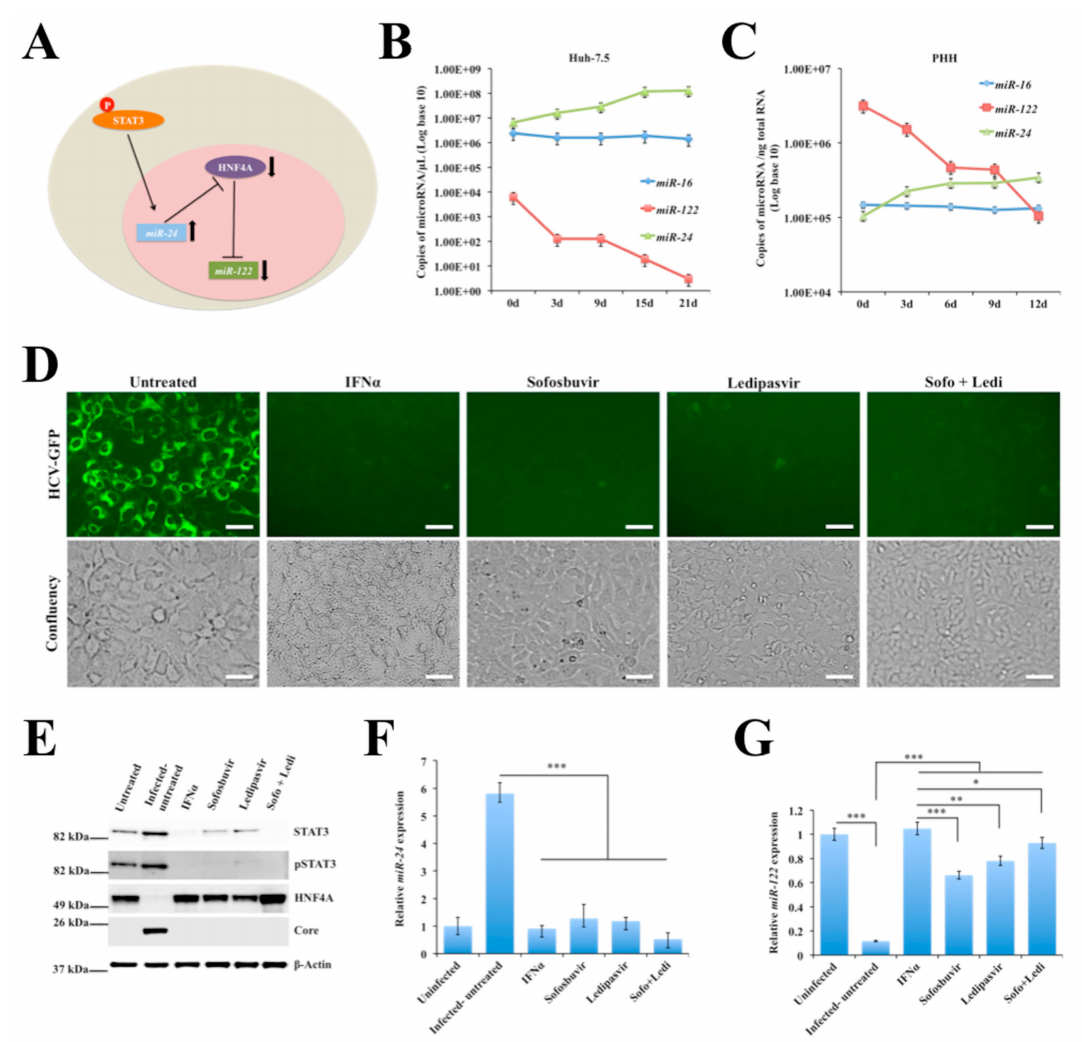
Figure 4. Relationship between signal transducer and activator of transcription 3 (STAT3)-hepatocyte nuclear factor 4 alpha (HNF4A) and the expression miR-122 and miR-24 in hepatitis C virus (HCV)-infected Huh-7.5 cells and primary human hepatocytes (PHHs). ( A ) Shown is the proposed hypothesis relating stress and STAT3- miR-24 -HNF4A- miR-122 feedback circuit in HCV infection. ( B ) Quantification of miR-16 , miR-24 and miR-122 levels in persistently HCV-infected Huh-7.5 cells by real-time RT-PCR analysis over 21 days. ( C ) Quantification of miR-122 , miR-24 and miR-122 levels in HCV-infected PHHs over 12 days. ( D ) Shown is the HCV-green fluorescence protein (GFP) expression in the infected culture with or without antiviral treatment. ( E ) Western blot shows the expression levels of STAT3 and HNF4A in the infected culture on day 9 with or without antiviral treatment. ( F ) The expression levels of miR-24 in HCV-infected culture before and after treatment with interferon alpha (IFN α ) or direct-acting antivirals (DAAs). ( G ) The expression levels of miR-122 in HCV-infected culture treated with IFN α or DAA. The results are expressed as the mean ± standard deviation (SD) of three experiments. Error bars represent SD. p -values were calculated by ANOVA between di ff erent groups as compared to untreated HCV-infected group. * p -value < 0.05, ** p -value < 0.01, *** p -value < 0.001. Original magnification × 40, scale bars = 25 µ